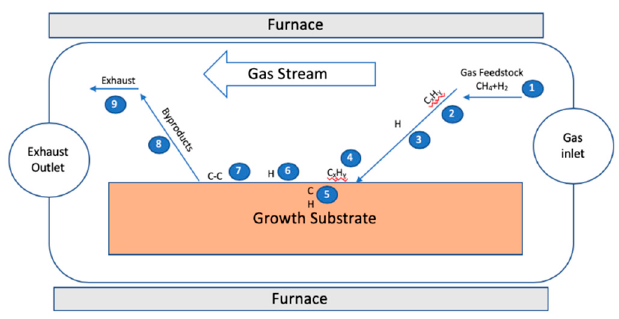
Figure 3. Schematic diagram of thermal CVD growth of graphene.